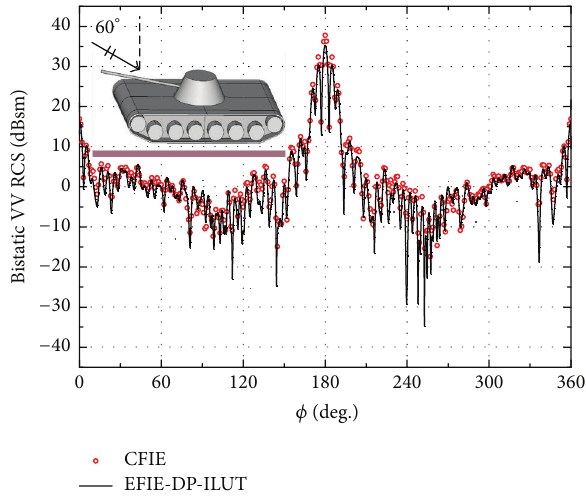
Figure 8: The V-polarized bistatic RCS patterns of the tank model above the half space in the 𝜃 = 80 ∘ cut at 1.5 GHz with EFIE-DP- ILUT and